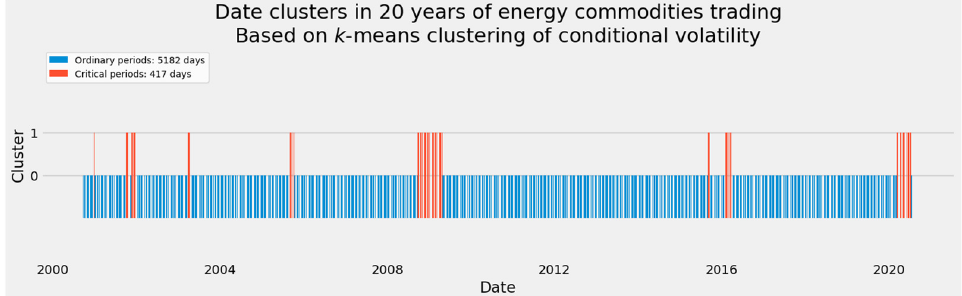
Figure 36. k-means clustering of energy-related markets—A simplified timeline showing the six smallest clusters, aggregated as indicators of critical events.